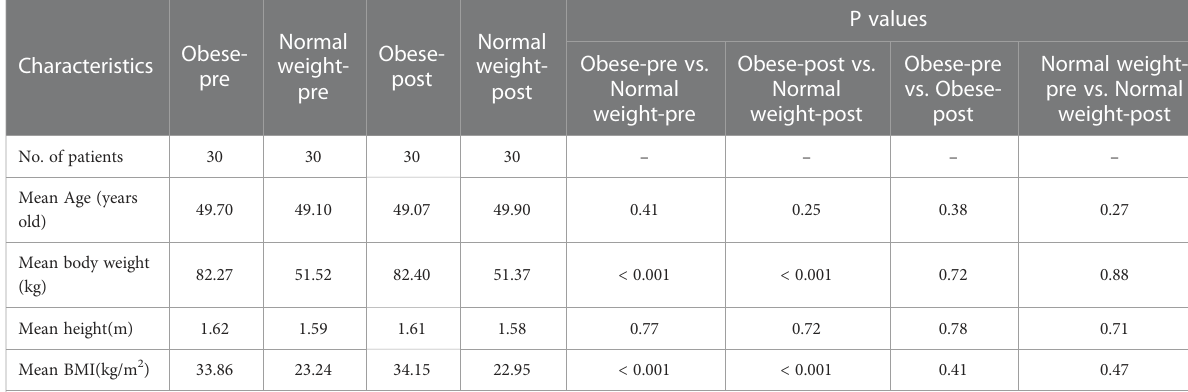
TABLE 2 Clinicopathologic characteristics of 120 patients in the second cohort. Characteristics